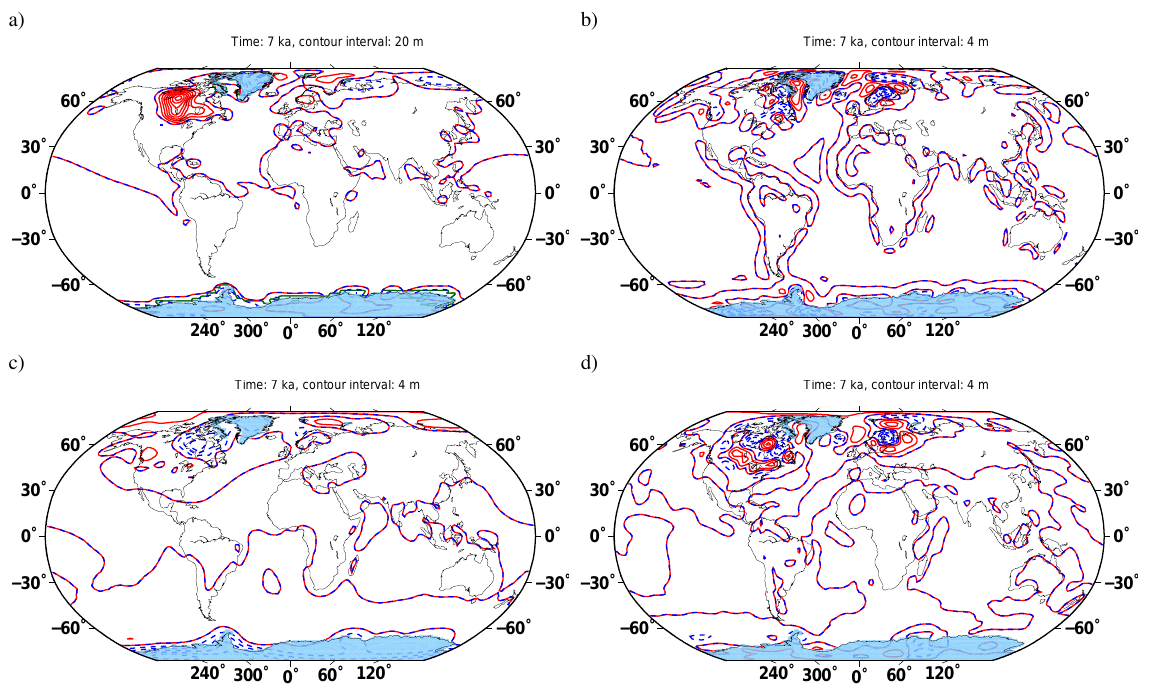
Figure 4. Sensitivity of relative sea-level data around the world to changes in ice-load history model (a) , lithospheric thickness variations (b) , background viscosity (c) , and lateral viscosity variations (d) at 7ka. Light blue areas mark the extent of ice sheets at the time, taken from the ICE-5G model (Peltier, 2004). Red and blue-dashed lines are contours with positive and negative sensitivity, respectively. The red-blue-dashed line marks zero sensitivity. Contour intervals indicated on top. Unit in m. To read the sensitivity of a certain line, count the number of lines from the zero-sensitivity line and multiply by the contour interval.